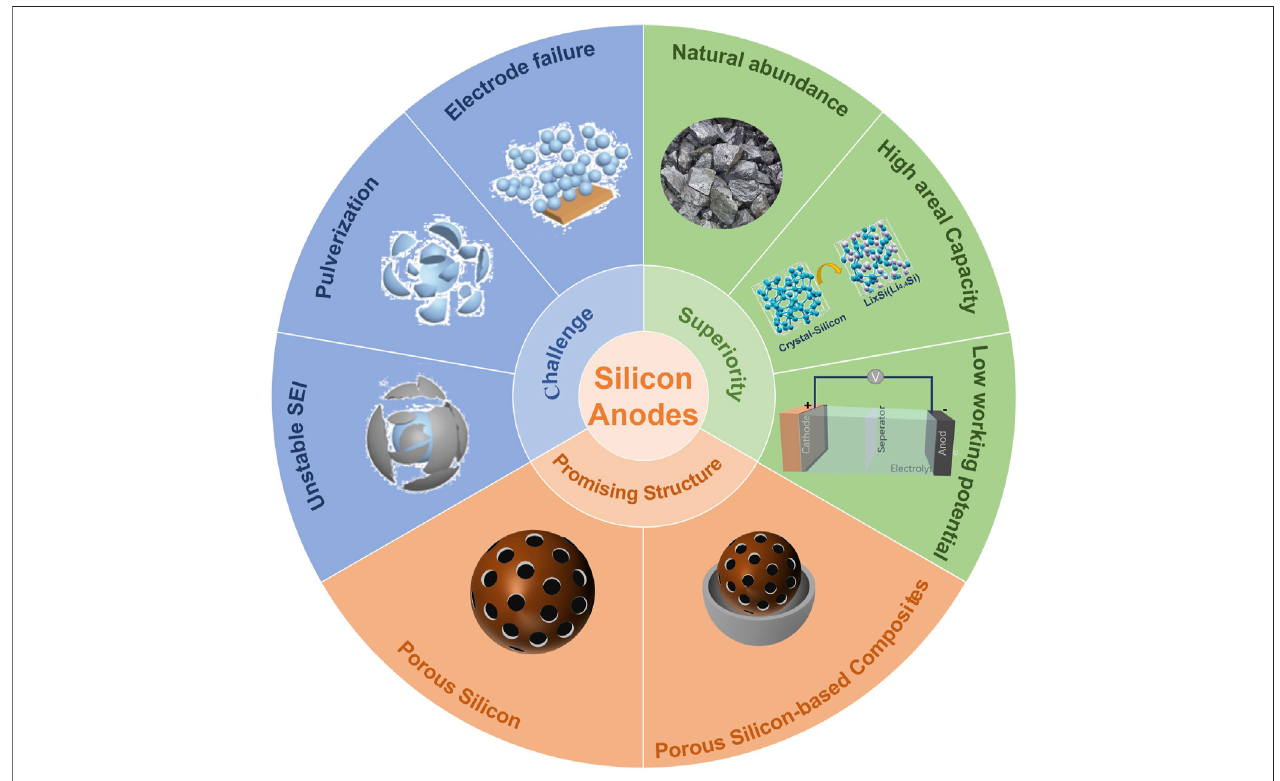
FIGURE 1 | An overview of silicon anodes: “ Challenge, ” “ Superiority ” and “ Promising Structure. ” The inserted graphics are adapted with permission from (Johari et al., 2011; Jin et al., 2017).